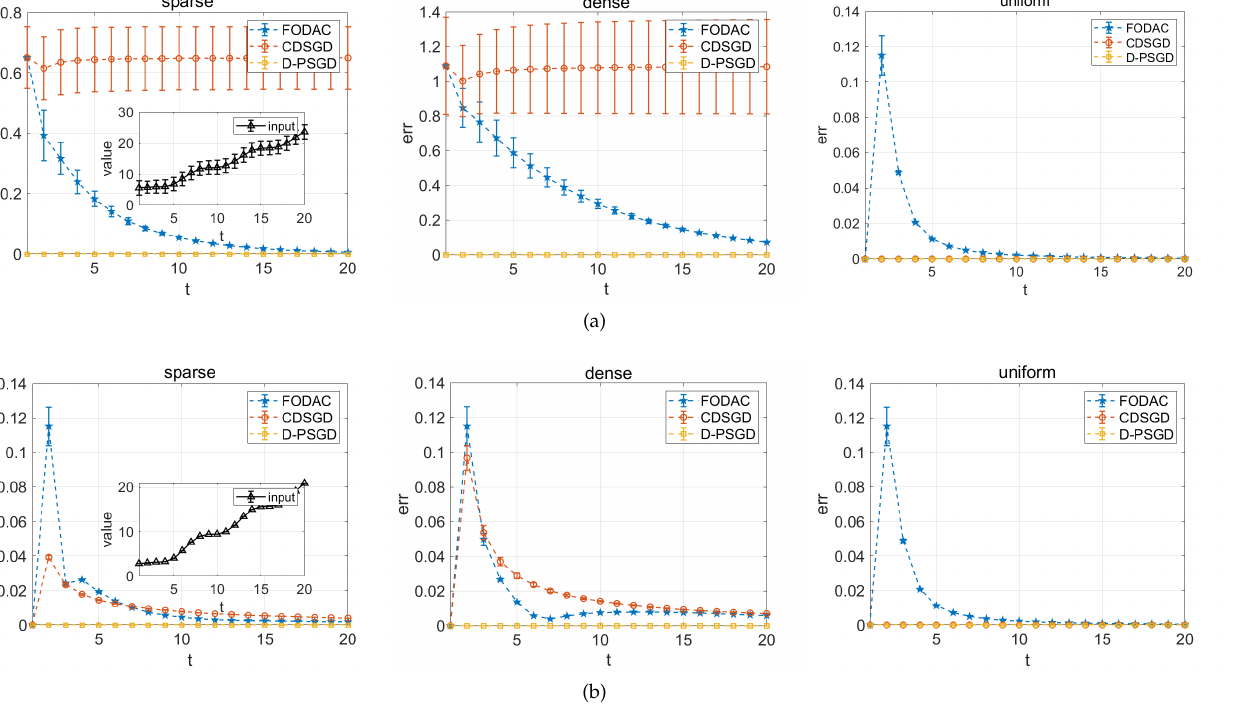
Figure 3. The result of approximating the average by different methods. ( a ) inputs with large variance; ( b ) inputs with small